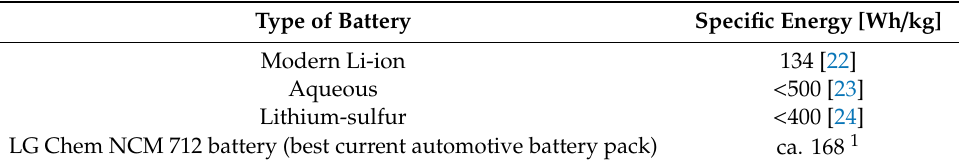
Table 1. Specific energy of